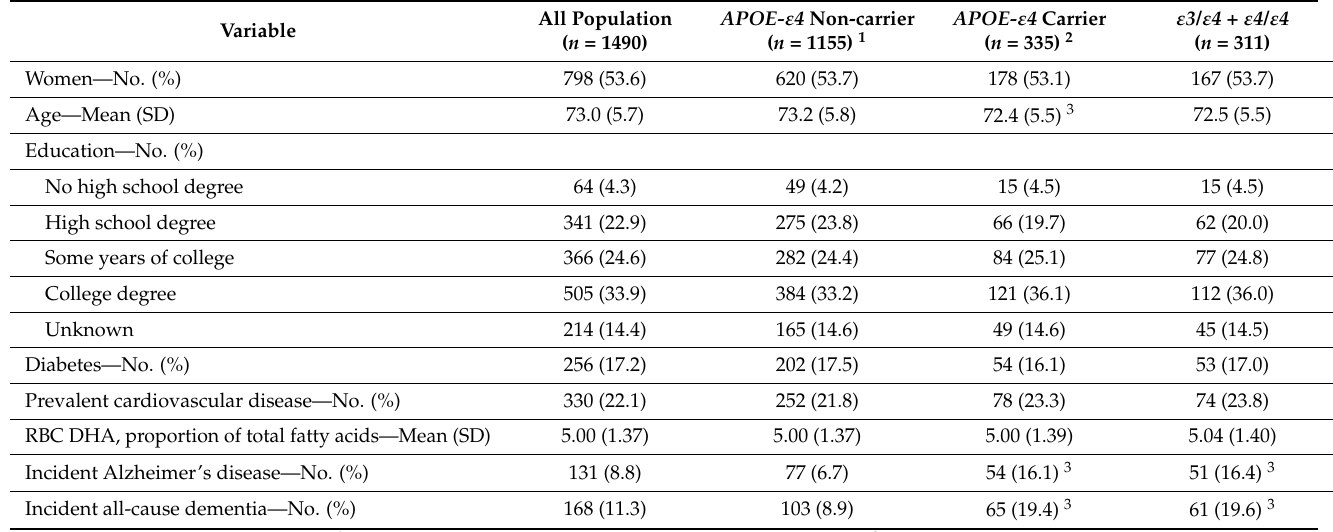
Table 1. Baseline characteristics and endpoints of the study population, overall and by APOE- ε 4 carriership.